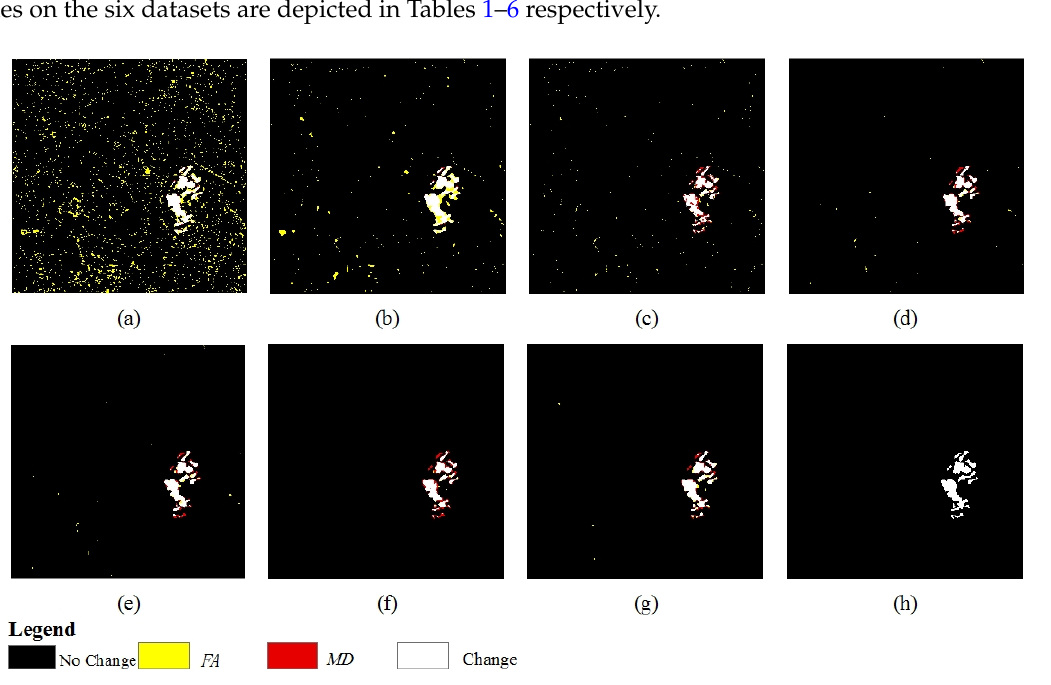
Figure 8. Final change detection maps of the Mexico dataset produced by ( a ) EM; ( b ) EMMRF; ( c ) FCM; ( d ) FLICM; ( e ) RFLICM; ( f ) sRSFCM; ( g ) proposed RSFCM; and ( h ) reference image.